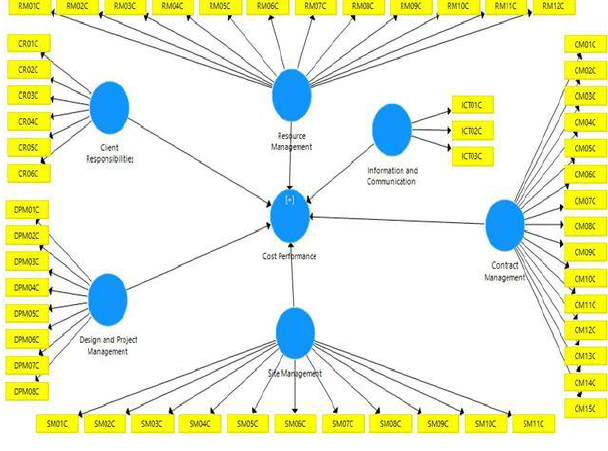
Fig. 1. Hypothetical